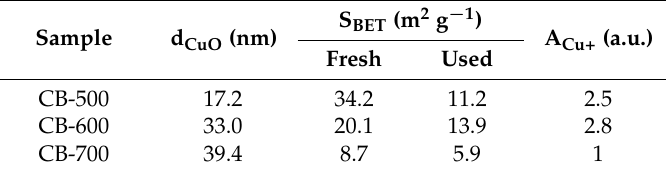
Table 1. Structural and textural data for the CuO-Bi 2 O 3